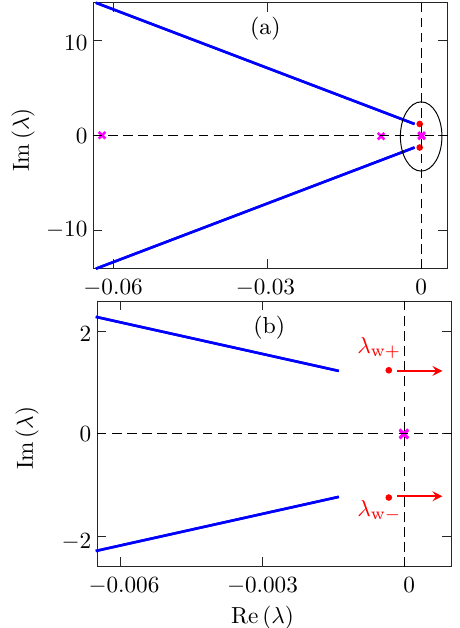
Fig. 2. An illustration of the spectrum of a modelocked laser Figure 2: The spectrum of a modelocked laser model with a slow model with a slow saturable absorber, where in (b), we show saturable absorber, where in (b), we show the spectrum near the the spectrum near the origin of (a). From left to right in (a) on origin of (a). From left to right in (a) on the real axis, the discrete the real axis, the discrete modes are the amplitude mode, the modes are the amplitude mode, the frequency mode, and the phase frequency mode, and the phase and time modes. The last two and time modes. The last two modes have eigenvalue modes have eigenvalue zero.